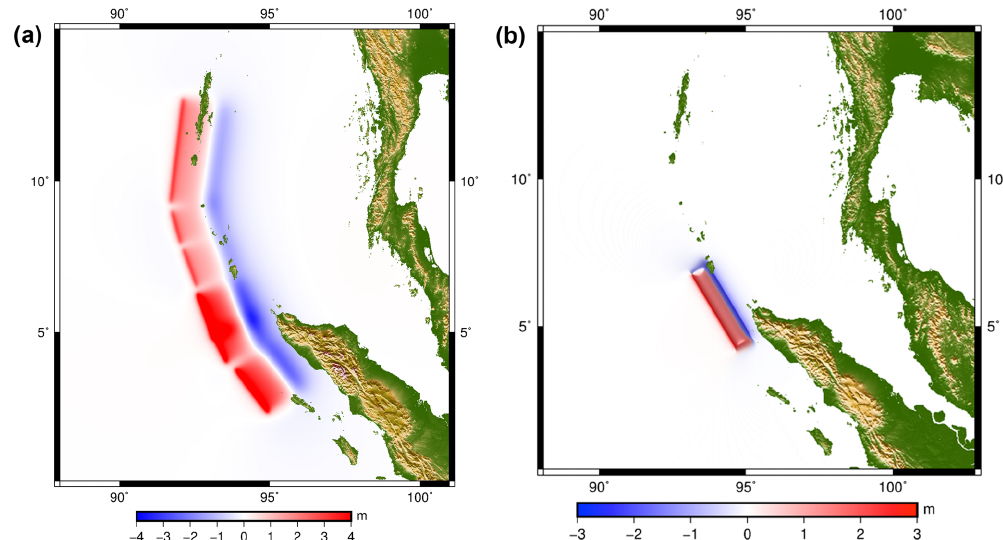
Figure 5. Initial wave forms of generated by the 9.15 M w earthquake as proposed by Koshimura et al. (2009) (a) and by a hypothetical earthquake of 8.5 M w (b)